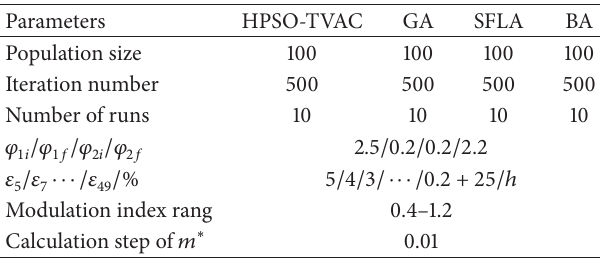
Figure 3: Calculated switching angles 𝜃 1 ∼ 𝜃 5 by HPSO-TVAC. Table 1: Parameters of evolution optimizers.